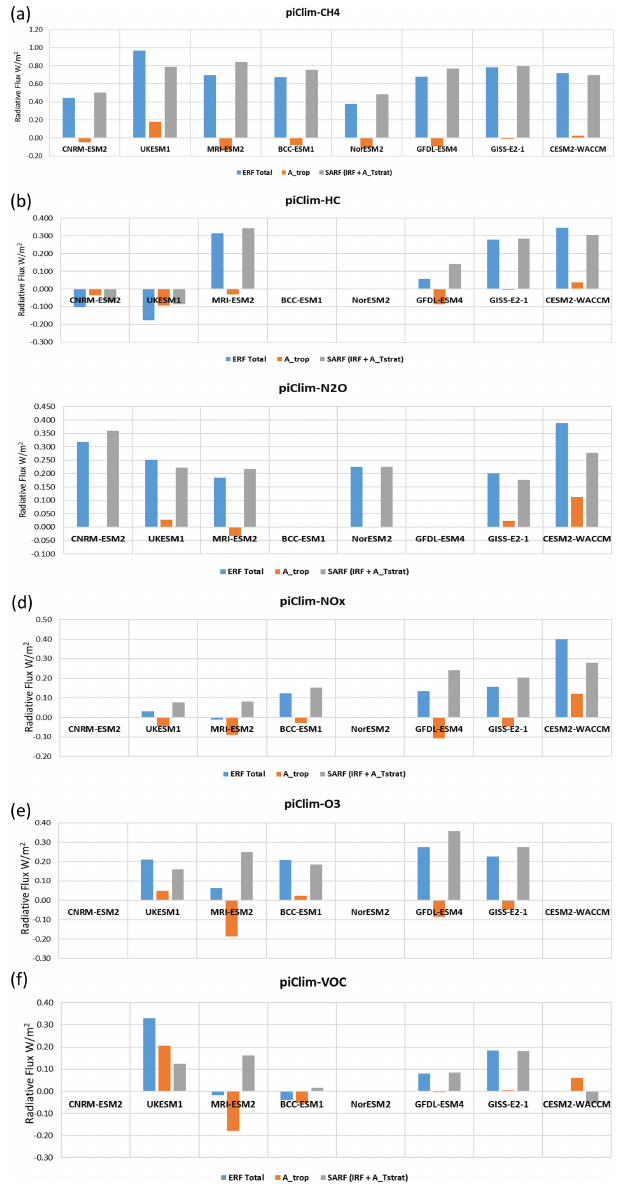
Figure 6. Breakdown of the ERF into SARF (IRF + A t_strat ) and tropospheric rapid adjustments ( A trop ) for the chemically reactive species (a) for piClim-CH 4 experiments, (b) for piClim-HC exper- iments, (c) for piClim-N 2 O experiments, (d) for piClim-NO x ex- periments, (e) for piClim-O 3 experiments and (f) for piClim-VOC experiments.